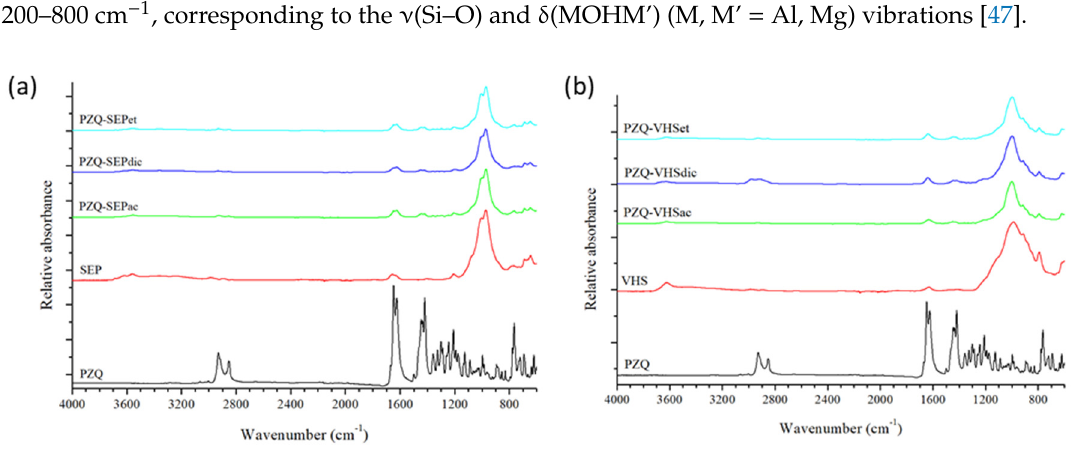
Figure 4. Fourier Transform Infrared (FTIR) spectra of sepiolite products ( a ) and of montmorillonite products ( b ).